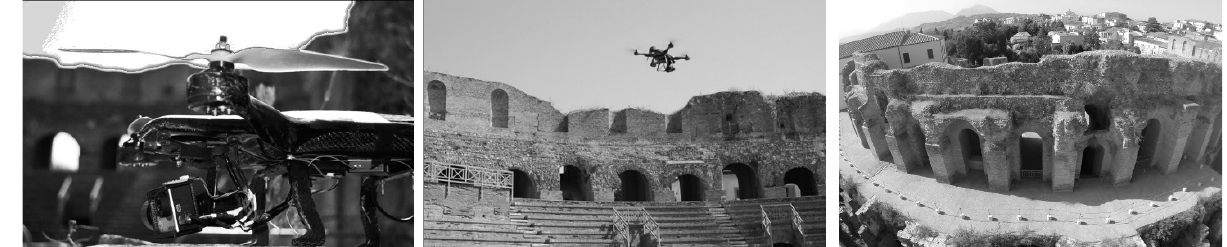
Figure 2: Theatre of Benevento, survey image-based with Unmanned aerial vehicle.